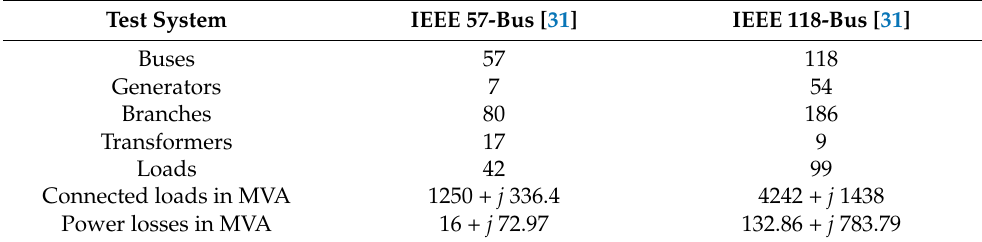
Table 2. Main specifications of the IEEE 57 and 118 bus systems.